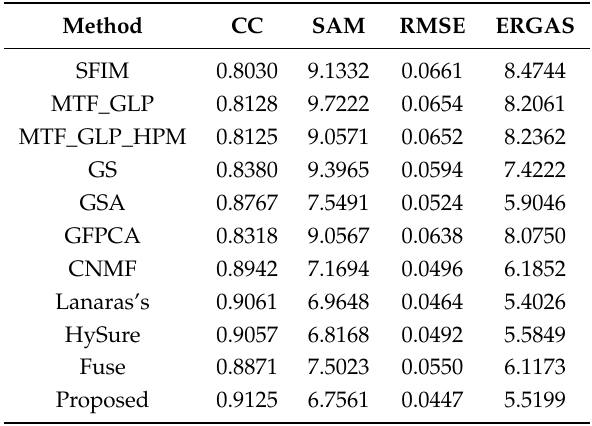
Table 4. Objective performance of eleven methods on the University of Pavia data set.